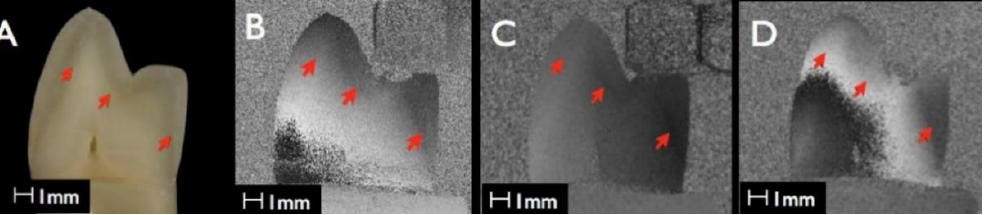
Figure 8. Natural tooth sample ( A ) under white light, ( B ) under a force of 35.5 N, ( C ) under a force of 40.23 N and ( D ) under a force of 82.54 N. Comparative mechanical behaviour of dentin enamel and dentin ceramic junctions assessed by speckle interferometry (SI). Adapted with permission from Ref. [102]. 2019, Elsevier.